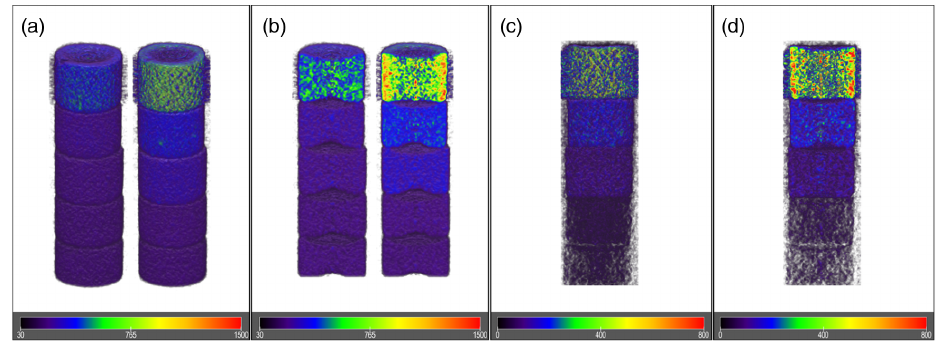
FIG. 7. (a) 3D volume rendering for tomographic images reconstructed from the KES-CT data and (b) its cut-surface. The volume rendering (c) and cut-surface (d) are for the subtraction between the two tomographic images. The contrast of these images is expressed using a pseudo-color